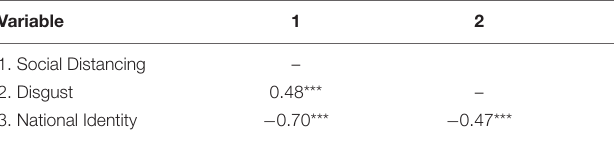
TABLE 1 | Study 1: Bivariate Pearson Correlations.